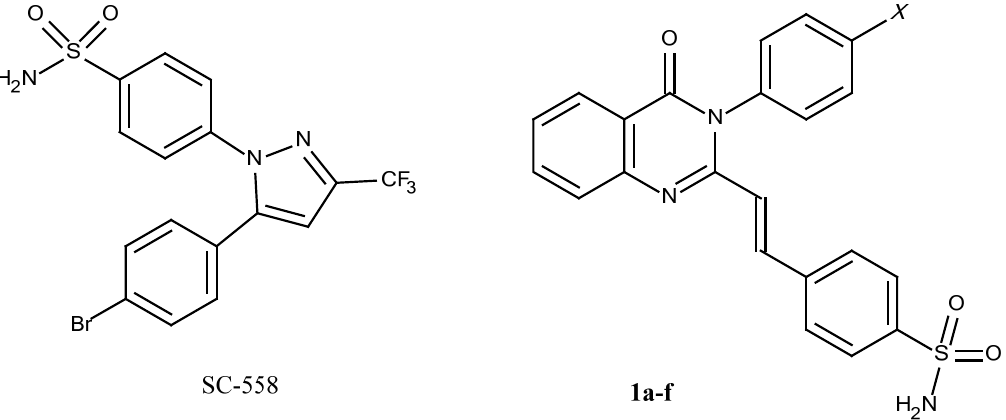
1a ( X = H); 1b ( X = CH Cl); compound 1f ( X = (C=O)OCH